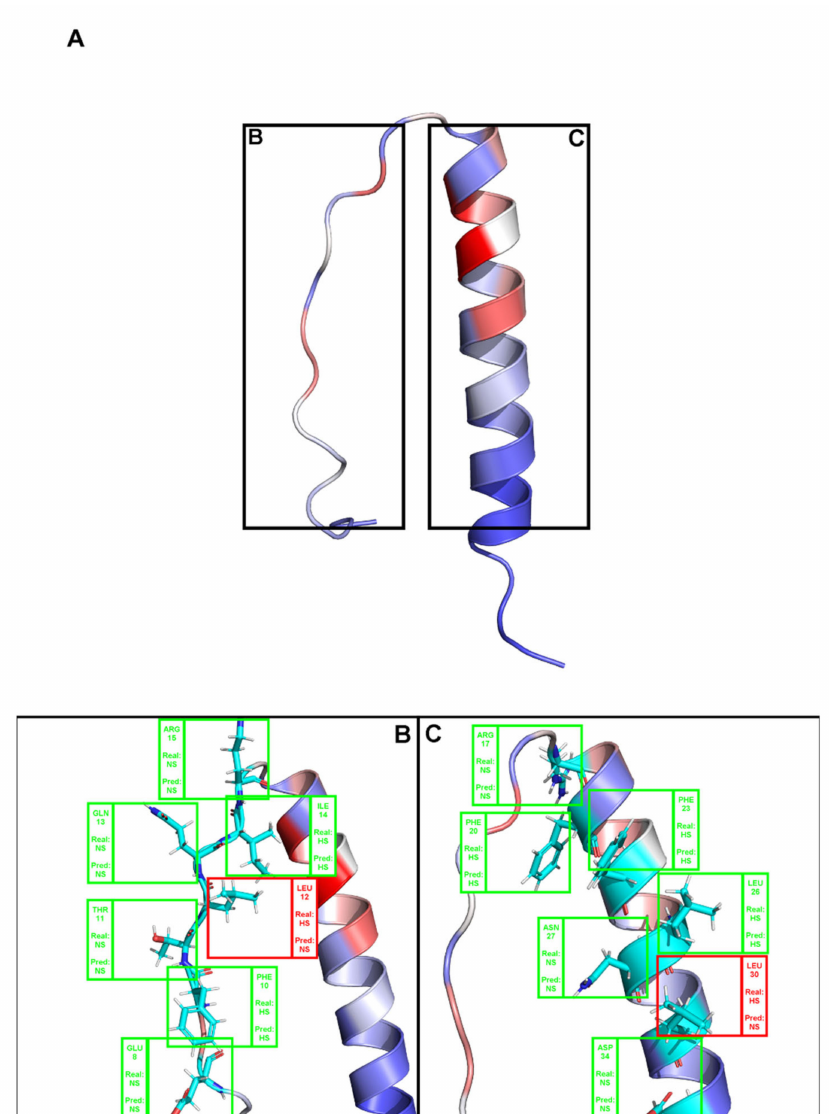
Figure A3. ( A ). Depiction of chain C of the complex PDB ID 3sak. Brighter red colors were attributed to residues with a higher probability of being classified as HS. ( B , C ) Close-ins of all interfacial residues for which there is an experimental ∆∆ G binding value, and as such a HS / NS classification. Green boxes represent correctly predicted residues, whereas red boxes represent incorrectly classified